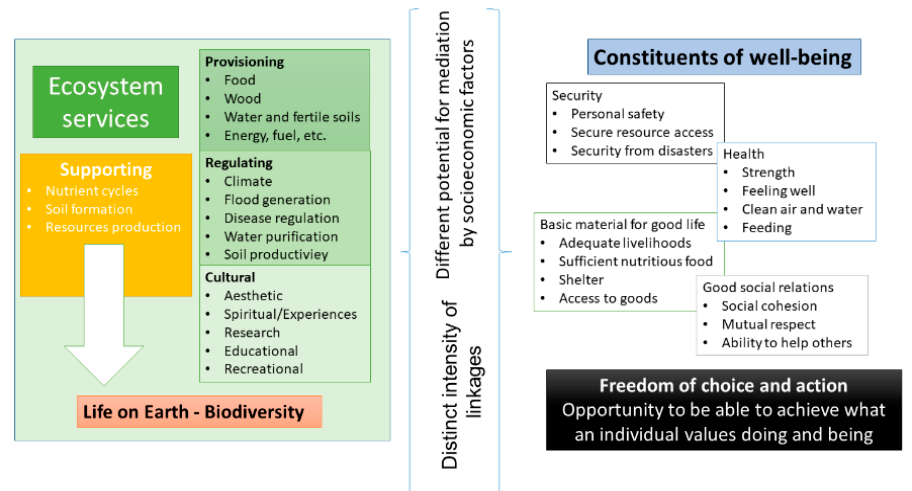
Figure 2. Reinterpretation of the intrinsic linkages between Ecosystem Services and Human Well- being (derived from the Millennium Ecosystem Assessment: Ecosystems and human well-being. Volume 1: current state and trends. Washington, DC. Island Press, 2005).